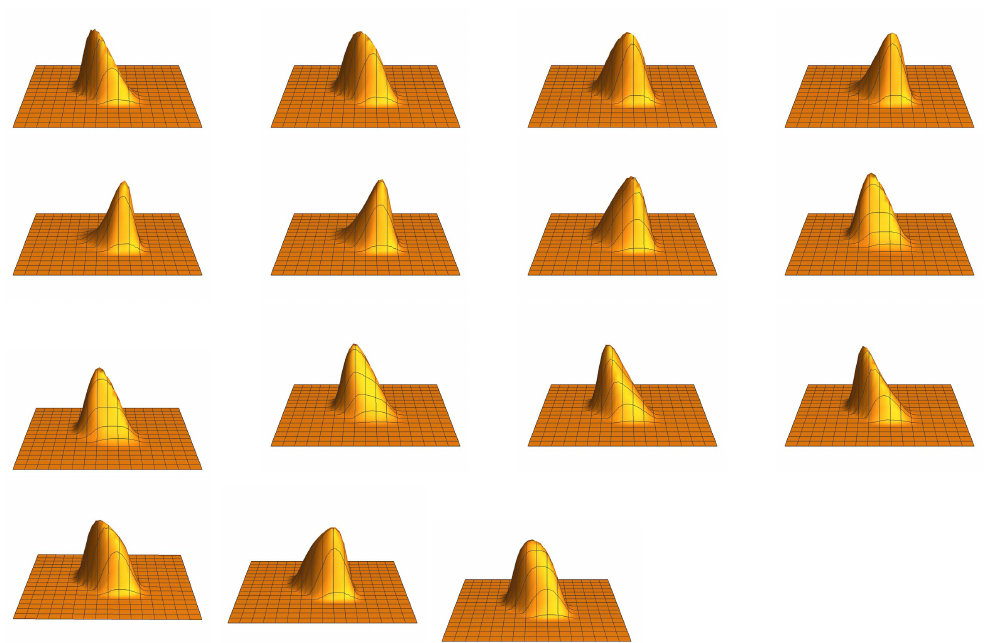
Figure 5. B-splines relative to a